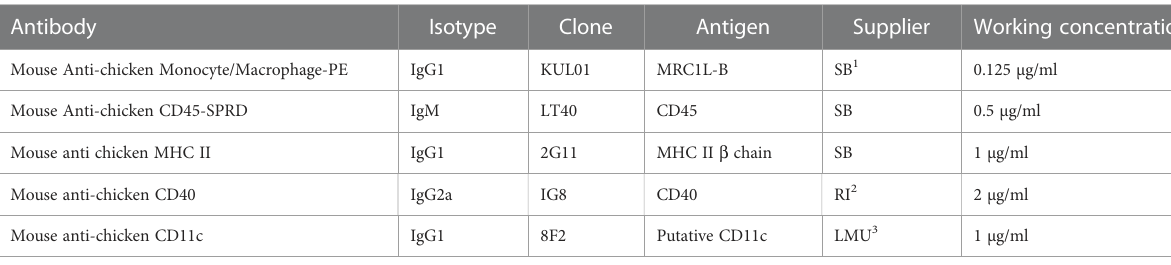
TABLE 1 Primary antibodies for the phenotypical analysis of BM-derived